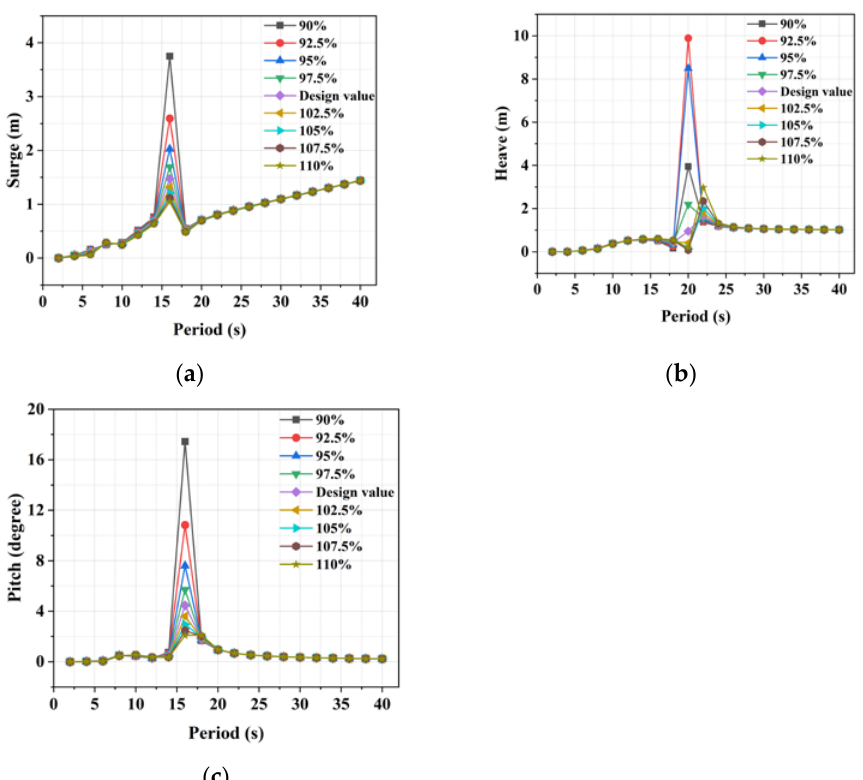
Figure 8. Motion transfer functions of the floating foundation with different column spacings: ( a ) Transfer function of surge motion; ( b ) transfer function of heave motion; ( c ) transfer function of pitch motion.